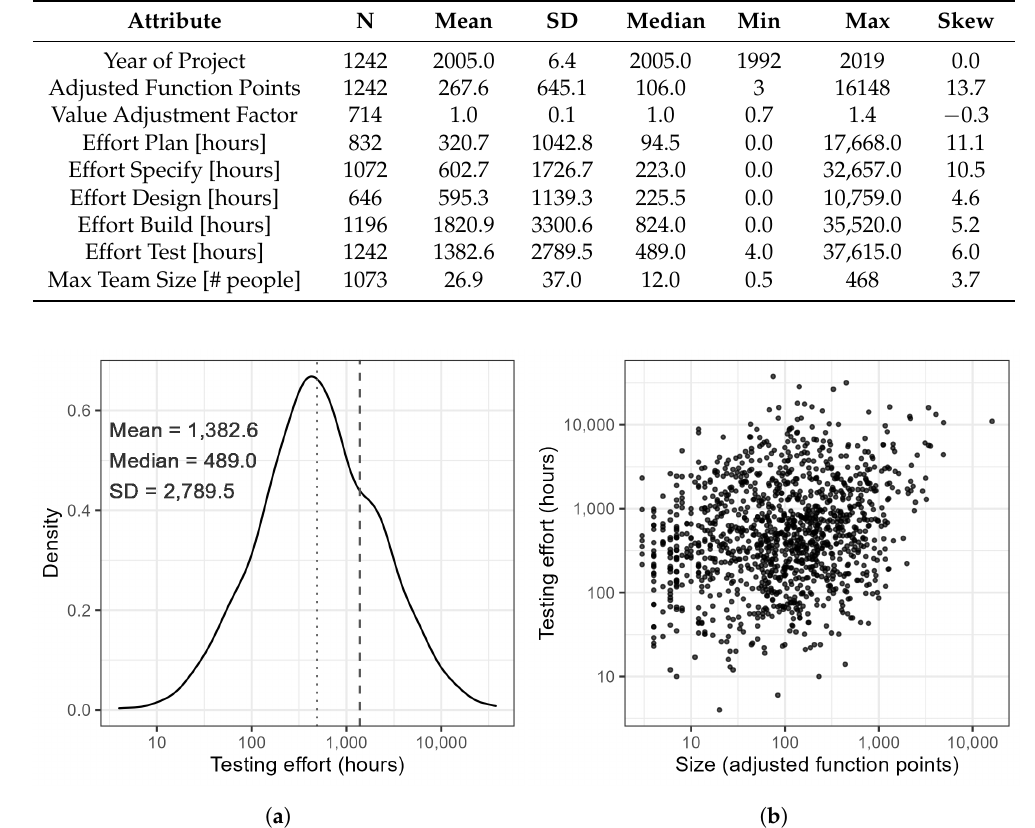
Figure 2. ( a ) Density of testing effort. ( b ) Scatterplot of size vs. testing effort. (Note the logged scale for size and testing